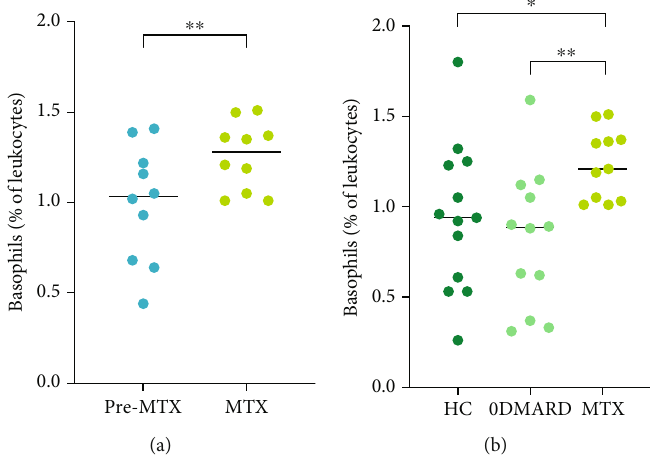
Figure 2: Percentage of basophils (of leukocytes) in peripheral blood from (a) patients with rheumatoid arthritis before methotrexate treatment and after 6-12 weeks on methotrexate, (b) healthy controls (HC), patients without disease-modifying antirheumatic drug treatment (0DMARD group), and patients on MTX treatment (MTX), before administration of 13-valent pneumococcal conjugate vaccine. Wilcoxon matched-pairs signed rank test and Mann – Whitney U test were used to calculate level of signi fi cance. Data are presented with medians. Table 3: Frequencies of circulating leukocytes in RA patients and HC, after vaccination with PCV13. Phenotype (% of leukocytes unless otherwise speci fi